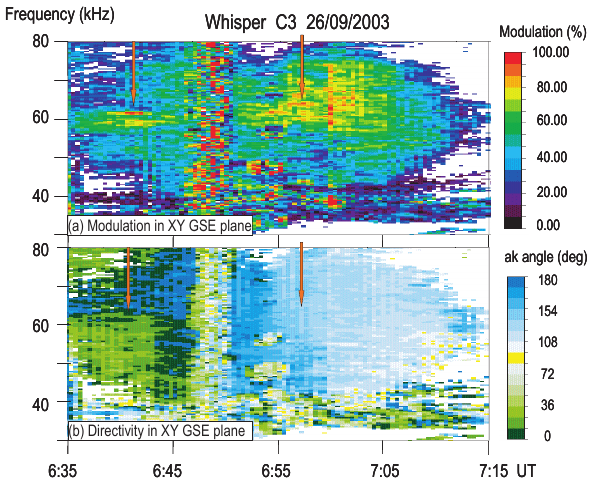
Fig. 2. Parameters derived from spin modulation of electric field intensity, plotted as frequency/time spectrograms: (a) modulation index m; (b) directivity angle ak. The orange arrows point to the high modulation